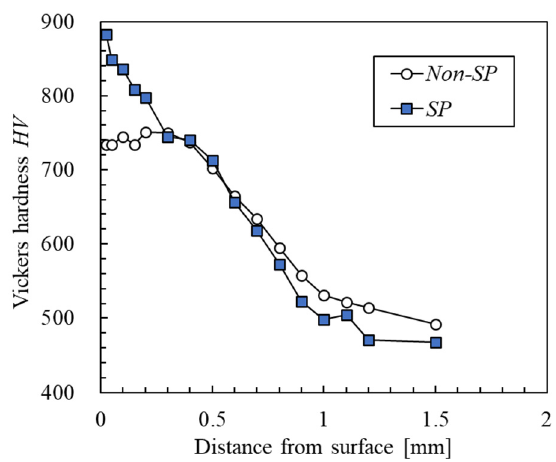
Figure 5. Distribution of Vickers